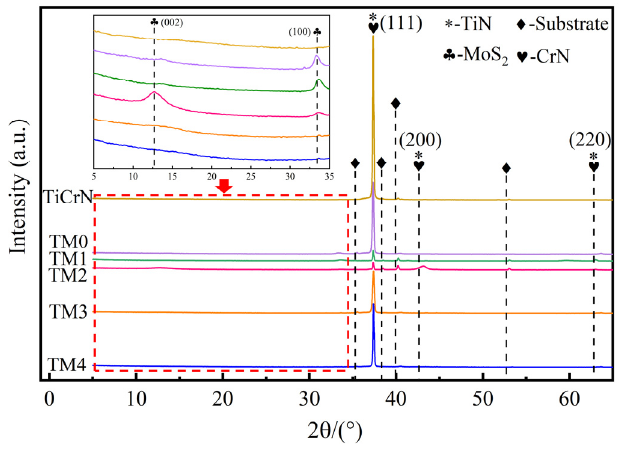
Figure 3. XRD patterns of as-deposited coatings.